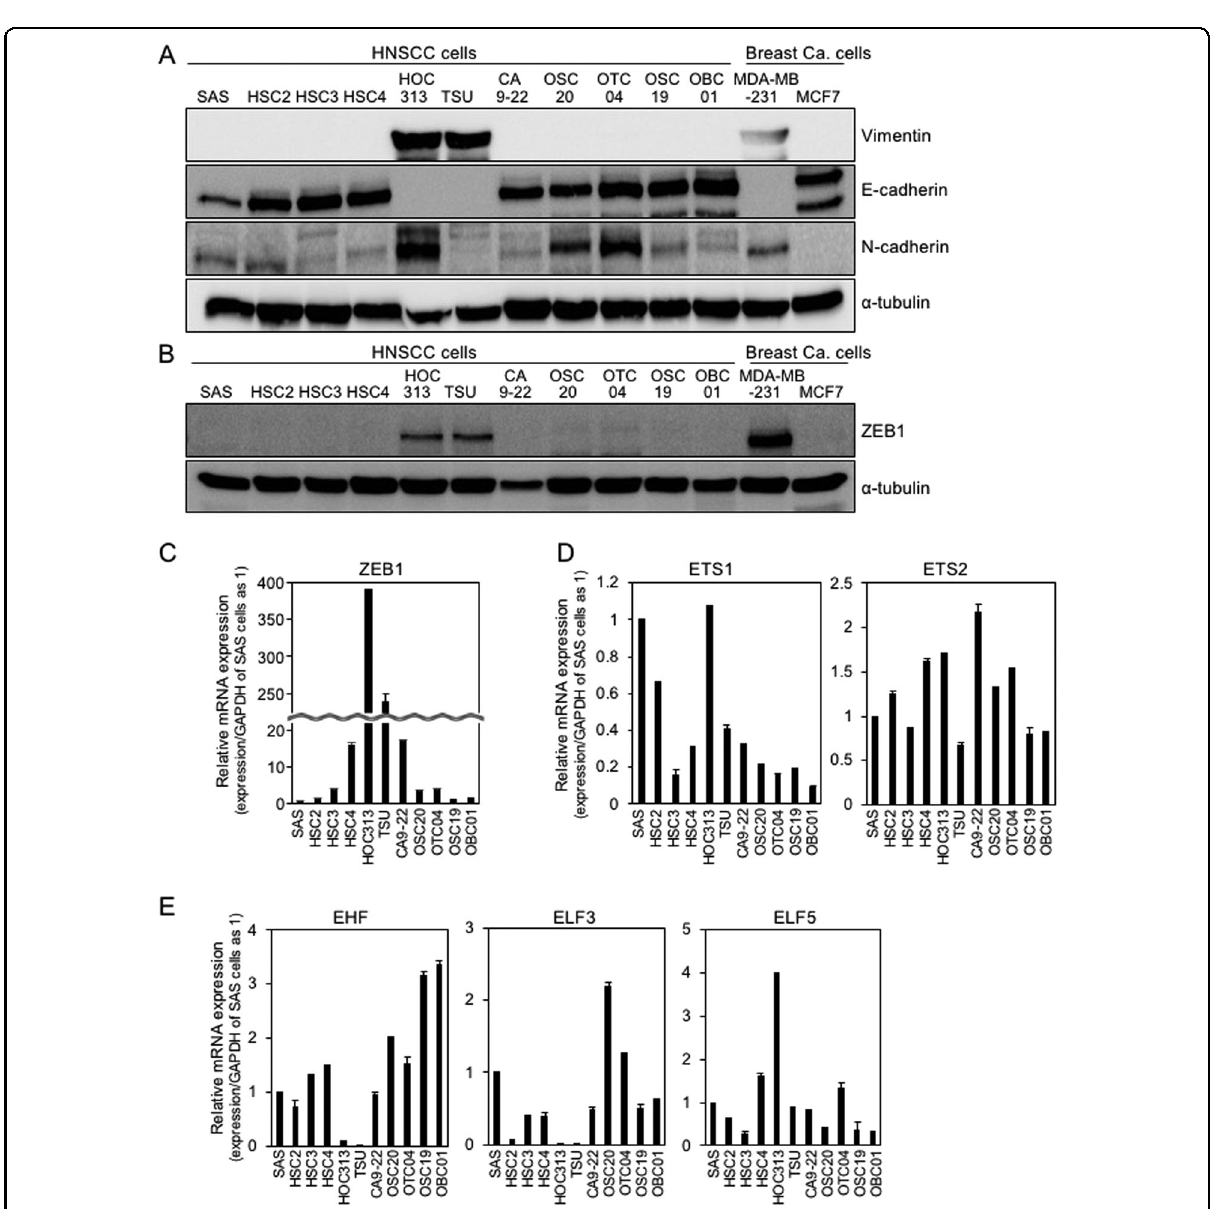
Fig. 1 EMT phenotypes in HNSCC cells. A, B, C, D, and E Representative markers of EMT in HNSCC cells were determined by IB and RT-qPCR. Breast cancer MDA-MB-231 and MCF7 cells were used as controls for ZEB1 expression levels. α -tubulin was used as a loading control ( A and B ). The ratio of each mRNA to GAPDH in SAS cells was indicated as “ 1 ” ( C , D , and E